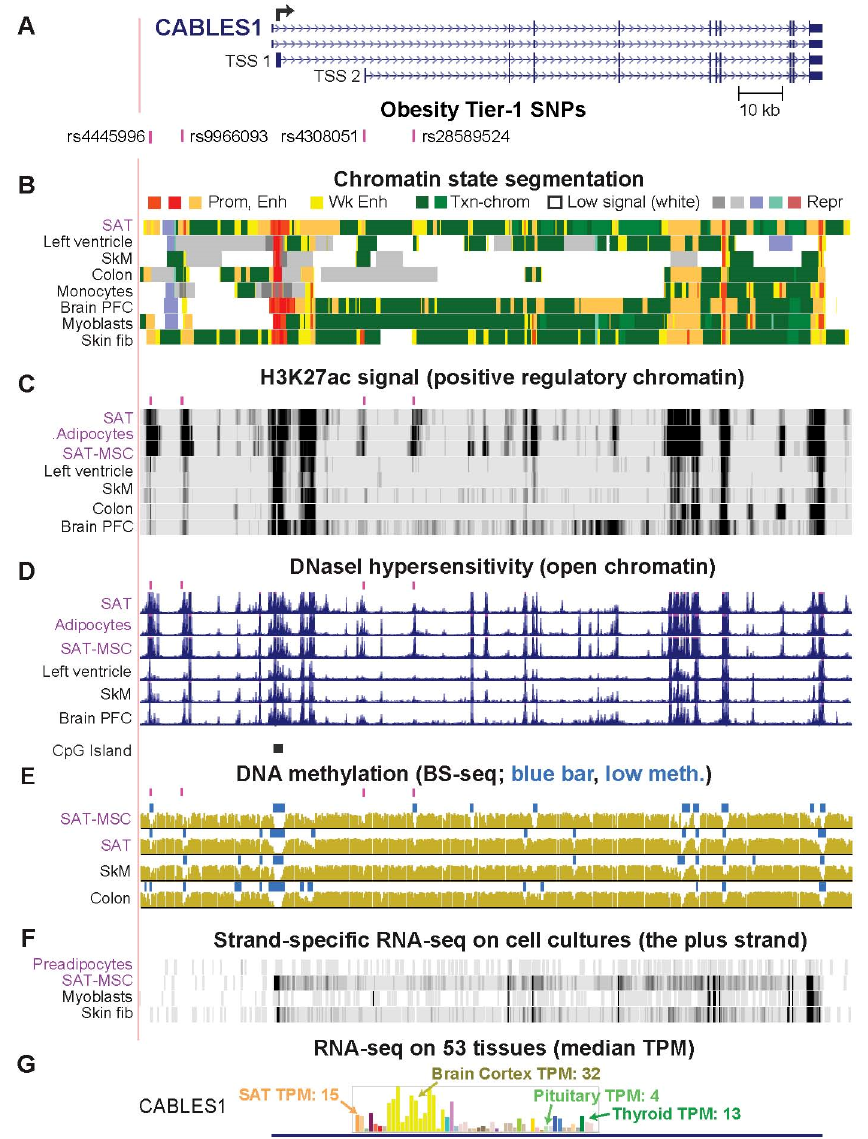
Figure 2. CABLES1 , which controls cell growth, is associated with Tier-1 SNPs that might regulate alternative usage of its widely separated TSS. ( A ) A 162-kb region containing CABLES1 and four prioritized regulatory SNP candidates (Tier-1 SNP) for obesity risk (chr18:20,684,550–20,847,013). The broken arrow denotes the most frequently used TSS. ( B ) Strong promoter (Prom) or strong enhancer (Enh) chromatin segments; weak enhancer chromatin (Wk Enh); chromatin with the H3K36me3 mark of actively transcribed regions (Txn-chrom); chromatin with low signals for the assessed histone modifi- cations (low signal); repressed (Repr) chromatin (8). ( C ) H3K27ac enrichment profiles (8). ( D ) Profiles of open chromatin (DNaseI hypersensitivity (8)) and a track for CpG islands, CpG-rich regions (13). ( E ) DNA methylation profiles from whole-genome bisulfite sequencing (BS-seq); blue horizontal bars indicate regions of significantly low DNA methylation (low meth) relative to the rest of the same genome. ( F ) RNA-seq on cell cultures (13); just the plus strand is shown with a vertical viewing range of 0–100. ( G ) Tissue RNA-seq depicted as a bar graph with median transcripts per million (TPM) from hundreds of biological replicates (12). First two orange bars, SAT and VAT (visceral adipose tissue); yellow bars, brain samples; see Supplementary Table S10 for details. SAT, subcutaneous adipose tissue; SkM, skeletal muscle; PFC, pre-frontal cortex; fib, fibroblasts; MSC, mesenchymal stem/stromal cells; short pink bars in panels ( C – E ), indicate positions of Tier-1 SNPs. All tracks were visualized in the UCSC Genome Browser (hg19) and are aligned in this figure and Figures